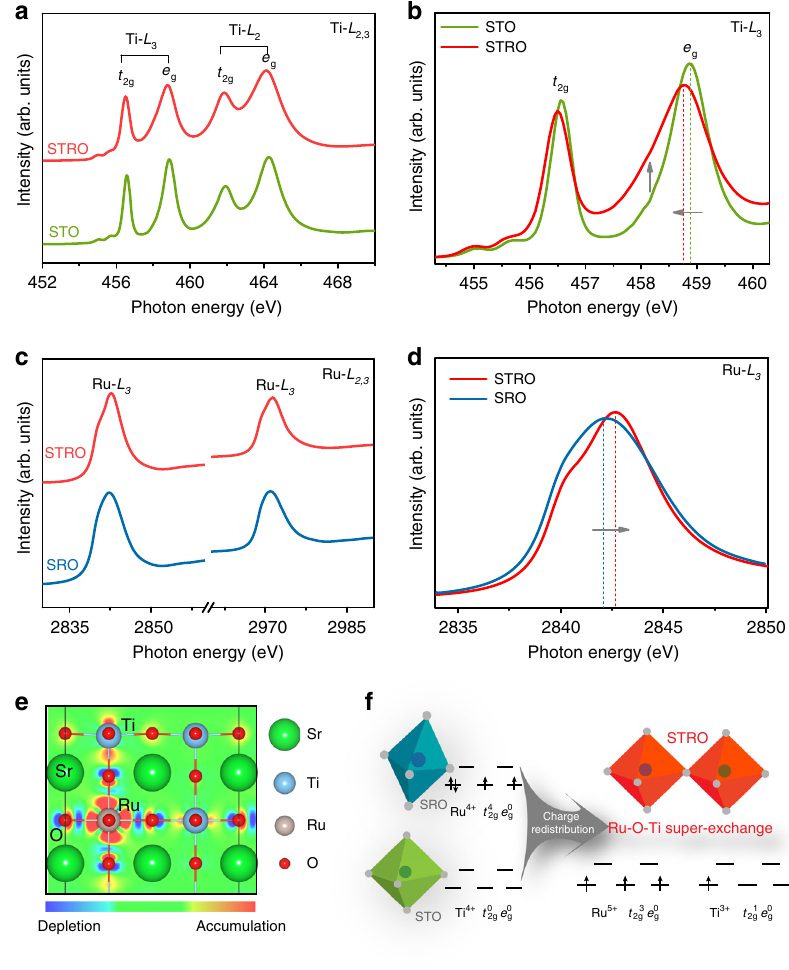
Fig. 4 Charge redistribution via super-exchange interaction. a Normalized Ti L 2,3 -edge XAS spectra of STO and STRO. b Enlargement of the Ti L 3 -edge XAS spectra of STO and STRO. c Normalized Ru L 2,3 -edge XAS spectra of STRO and SRO. d Enlargement of the Ru L 3 -edge XAS spectra of STRO and SRO. e Top view of the charge distribution in STRO. f Schematic illustration of the super-exchange interaction in